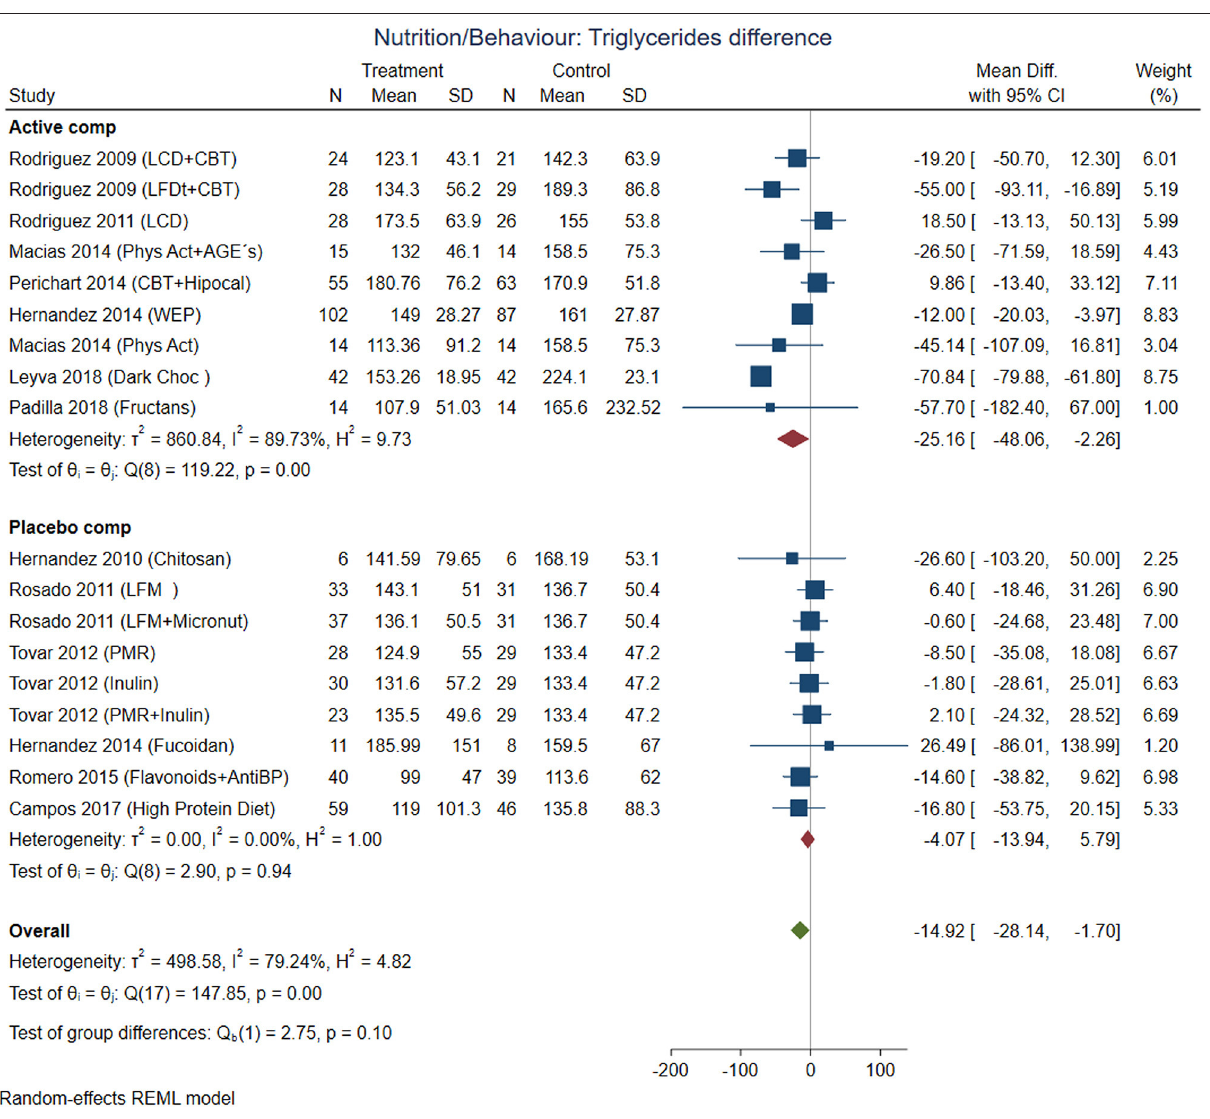
FIGURE 5 | Pooled analysis of Cohen’s d-weighted effect size on serum triglycerides concentration with nutritional and behavioral interventions. The analysis was stratified by placebo or active comparator. LFDT, Low fat diet; LCD, Low carbohydrate diet; CBT, Cognitive-behavioral therapy; Phys Act, Physical activity; Dark Choc, Dark chocolate; AGE, Advanced glycation end-product; Hipocal, Hypocaloric diet; WEP, Water and Education Provision; LFM, Low fat milk; Micronut, Micronutrients; PMR, Partial meal replacement; AntiBP, Antihypertensive medication; REML, Restricted maximum